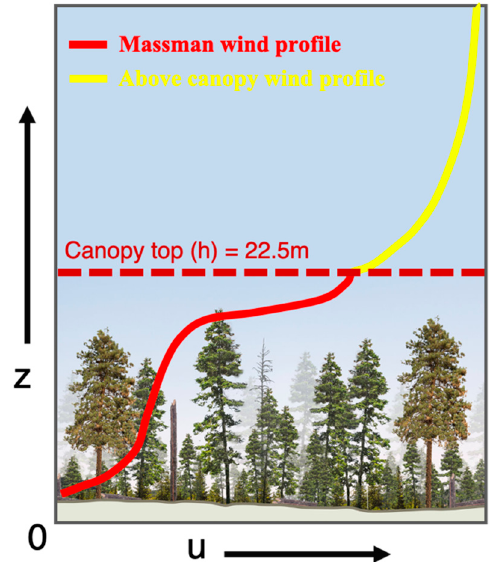
Figure 3. An illustration of the method used to extrapolate above canopy WRF winds to the canopy floor using the ICM parameterization.